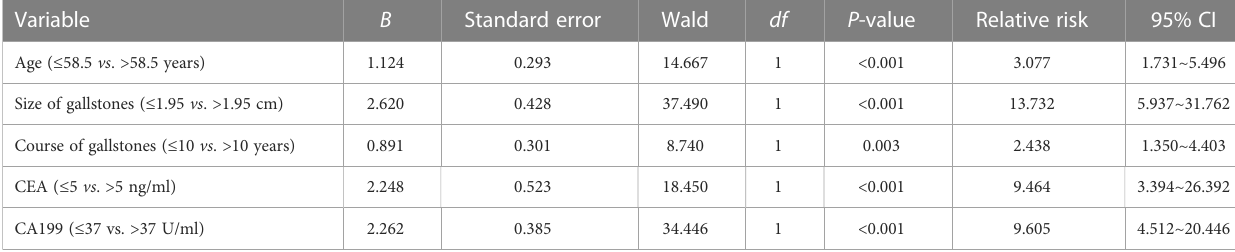
TABLE 2 Logistic multivariate analysis of the risk factors associated with GBC in patients with gallstones in the internal test samples.